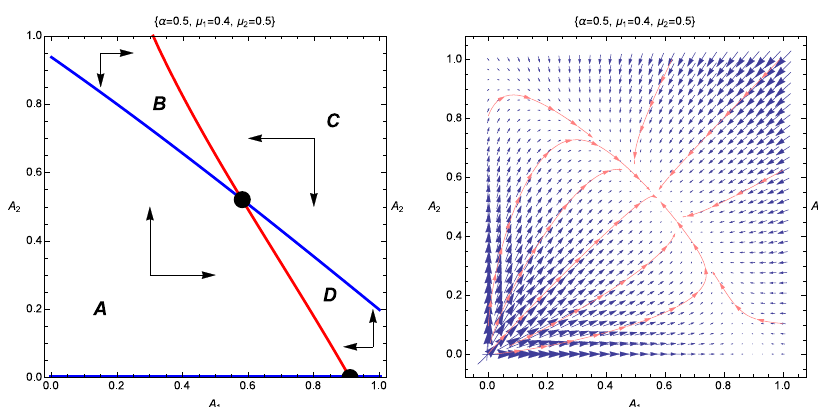
Fig. 2 The left panel represents the phase diagram of the system. The red line corresponds to the pairs ( A , A ) such that (cid:7) A ( t ) = 0. The blue lines to the pairs ( A , A ) such that (cid:7) A ( t ) = 0. When 1 2 1 1 2 2 ∗ (cid:7) A ( t ) = 0 for all A = 0. When (cid:7) A ( t ) = 0 defines a decreasing function in 2 1 , in the stationary state A 2 2 < 1 and 0 < A ∗ < 1. In this case, the intersection of the described line A 1 , in the stationary state 0 < A ∗ 1 2 with the red line defines four regions: A, B, C and D. The arrows in each region indicate the direction of a change in the outlets’ audiences. The right panel represents the vector field. In both panels, we consider α = 0 . 5, μ = 0 . 4 and μ = 0 . 5 1 2 μ = 0 . 4 and μ = 0 . 5. The left panel shows the pairs ( A , A ) such that (cid:7) A ( t ) = 0 1 2 1 2 1 (in red) and (cid:7) A 2 ( t ) = 0 (in blue). As observed, there are two stationary states: In